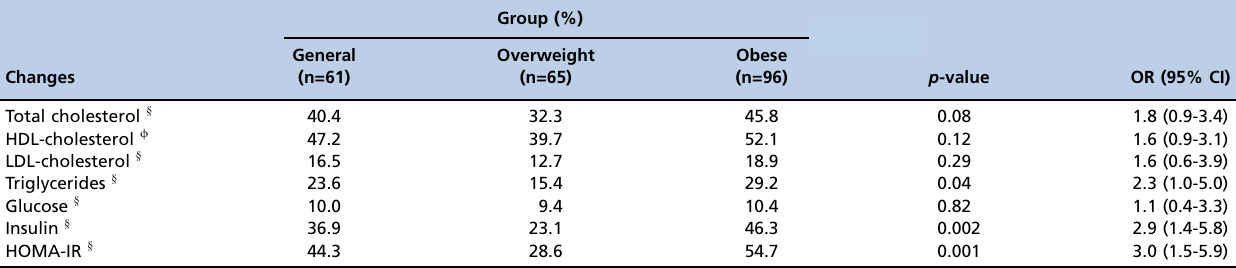
Table 3 - Percentage of laboratory changes in overweight and obese children and adolescents recruited from the public schools of the Municipality of Uberaba, Minas Gerais State, Brazil, from February 2013 to July 2014. Group (%)